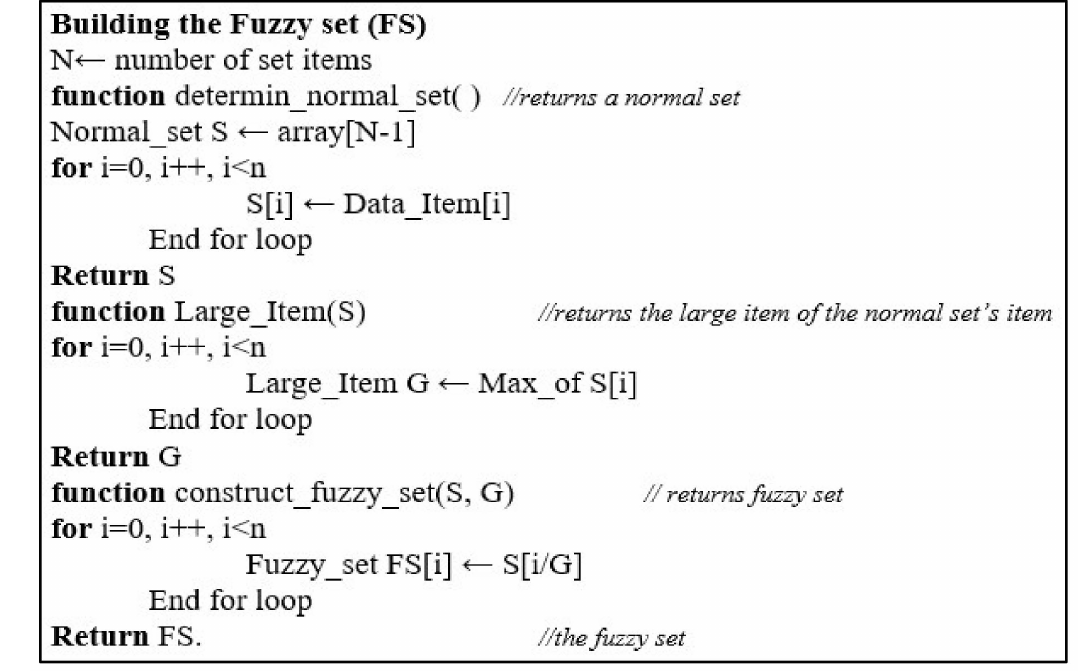
Figure 3. Building the fuzzy set’s